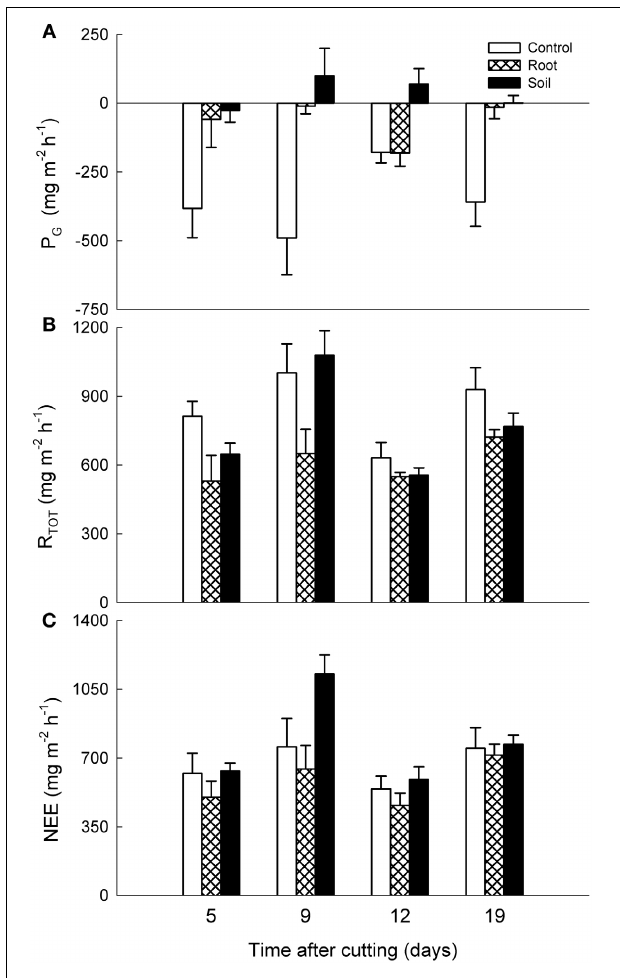
FIGURE 5 | Effects of experimental manipulations on CO 2 exchange in Deschampsia mesocosms. Mean ( + SE, n = 3) (A) gross photosynthesis (P G ), (B) dark ecosystem respiration (R TOT ), and (C) net ecosystem exchange (NEE) with intact vegetation (control), cut aboveground vegetation (root mesocosms) and all vegetation removed (soil mesocosms) as function of time after cutting. Positive values denote carbon loss and negative values carbon uptake into the